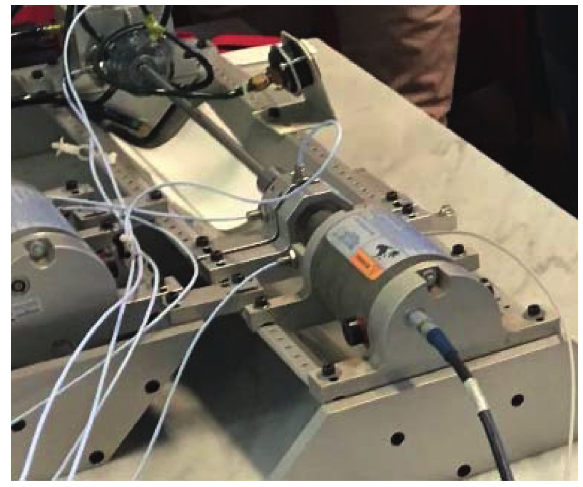
Figure 5: Rotor assembly mounted with custom shaft in config- uration 1.